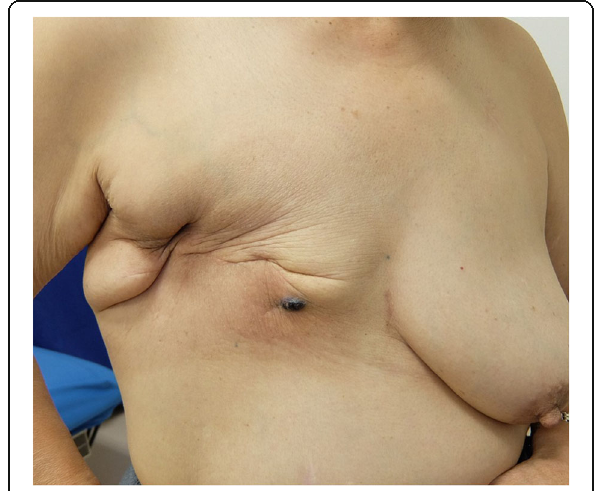
Fig. 1 Light pigmentation and a dark red tumor localized to the right chest wall of the